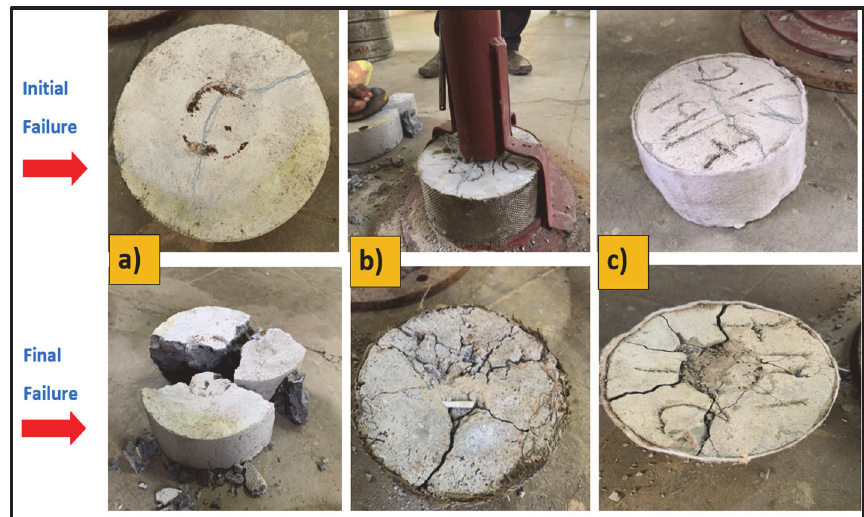
Figure 11: Crack formation during initial and final failure (a) Plain concrete sample (b) Basalt fiber wrapped sample and (c) Geotextile fiber wrapped